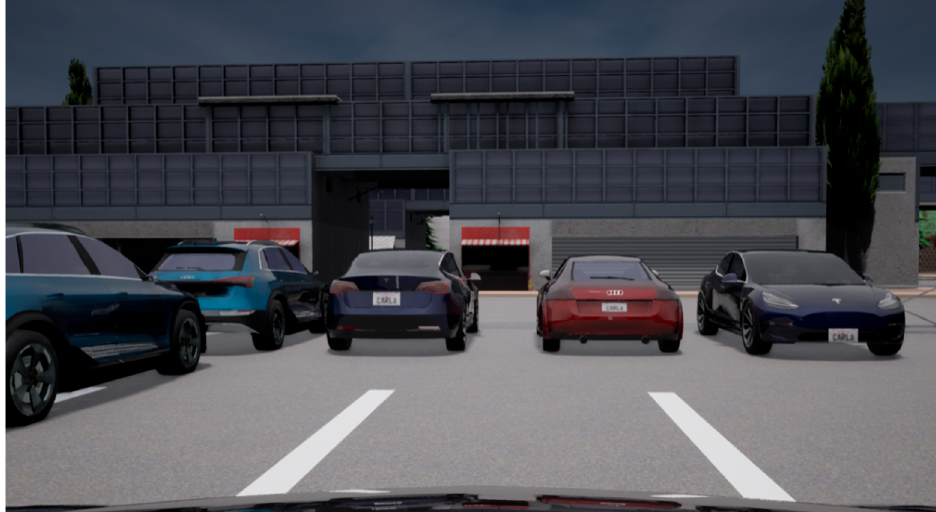
Figure 19. CARLA parking scenario forward view.